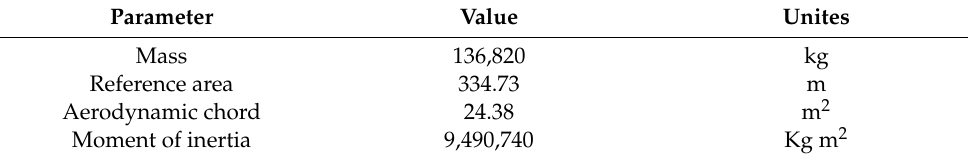
Table 2. Parameters of AHV.